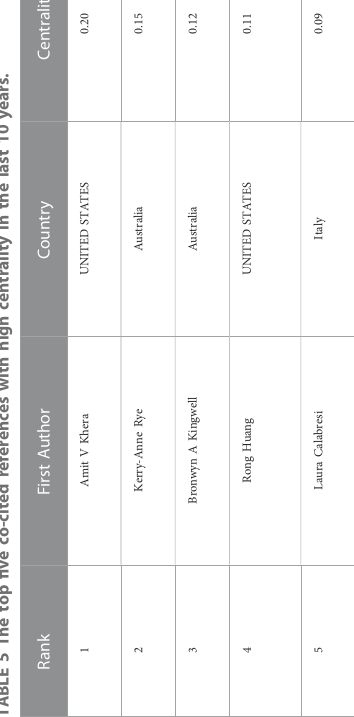
cellular synthesis of HDL (Pownall and Ehnholm,